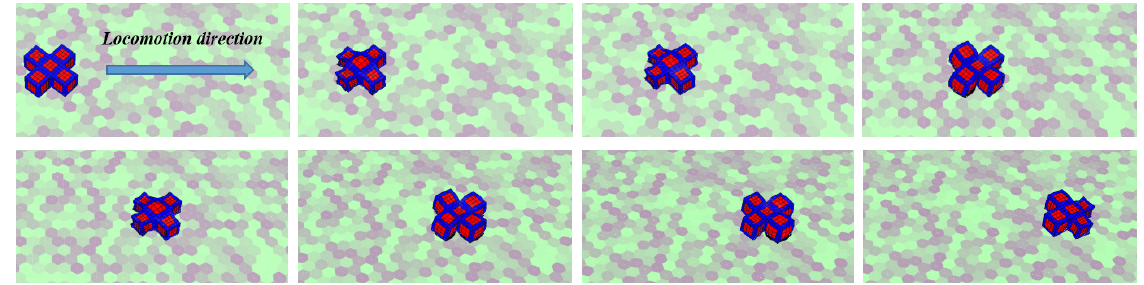
Figure 14. Locomotion Process of quadruped-like configuration in VOXCAD.